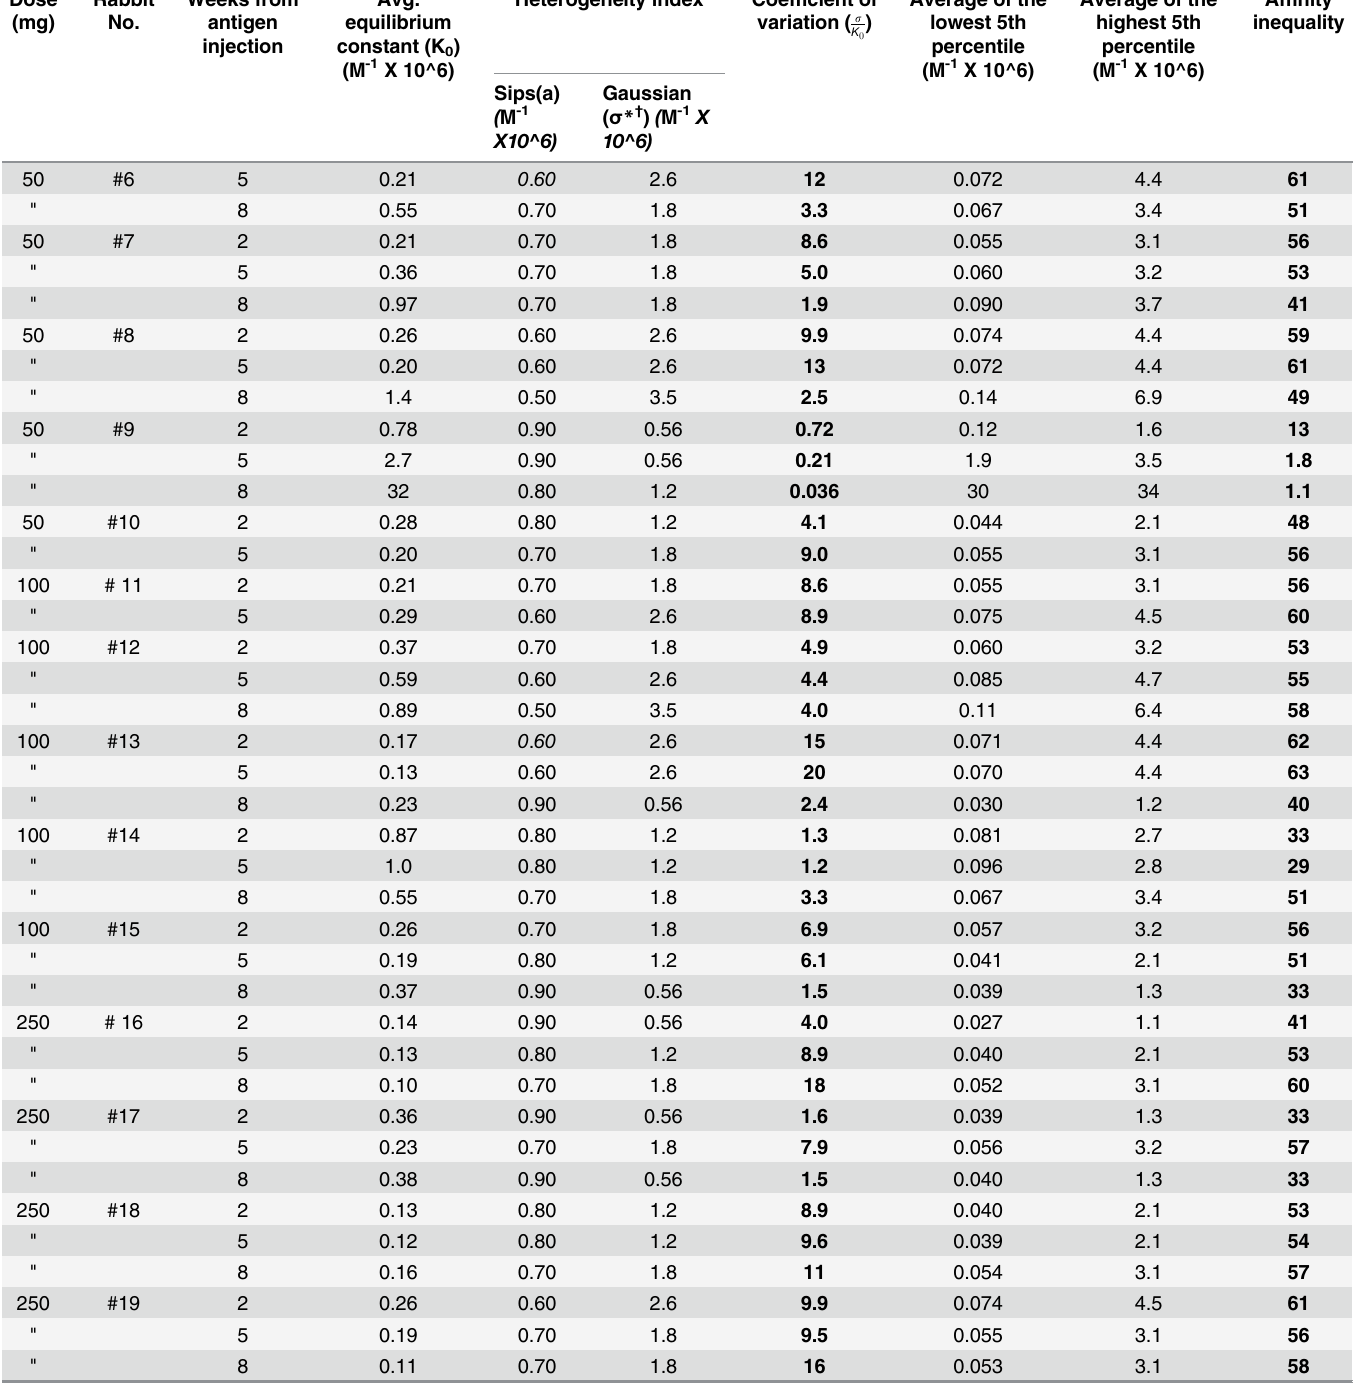
Table 2. Affinity inequality of antibodies after injection of high dose of the immunogen in rabbits. Dose Rabbit (mg)